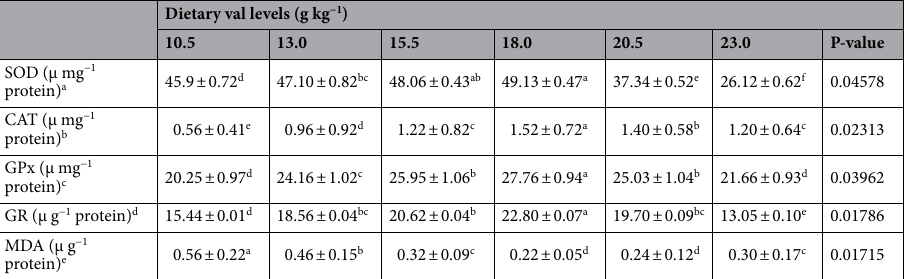
Table 4. Effects of dietary valine levels on intestinal antioxidant enzymes of rainbow trout, Oncorhynchus mykiss fingerlings for 8-weeks (mean values of 3 replicates + SD; n = 3). a SOD: Superoxide dismutase. b CAT: